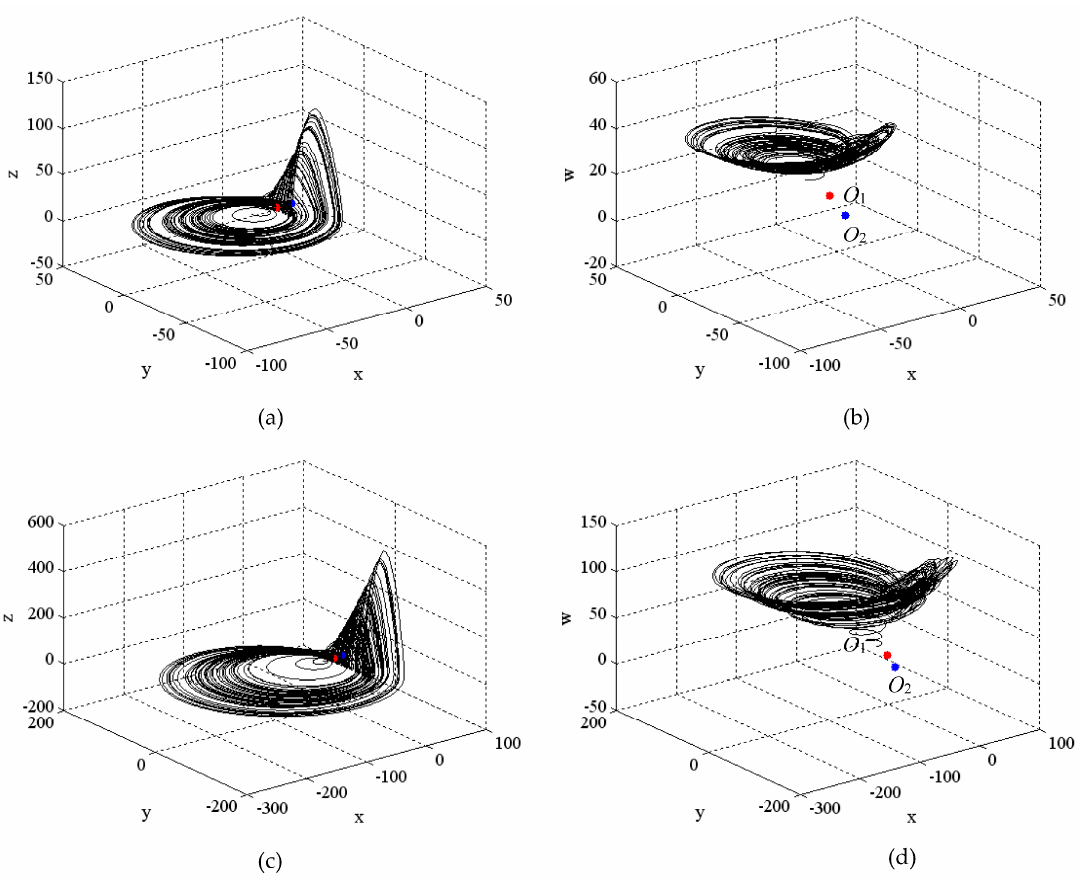
Figure 2. Phase space of system (2) in hyperchaotic regime when ( a , b ) a = 0.25, b = 3, c = 0.5, d = 0.05, b 2 = − 0.1, b 3 = 0.1, b 4 = 0.1 with b 1 = 0.1; ( c , d ) b 1 = 1.2. The first equilibrium O 1 is marked with red color and the second equilibrium O 2 is marked with blue color.